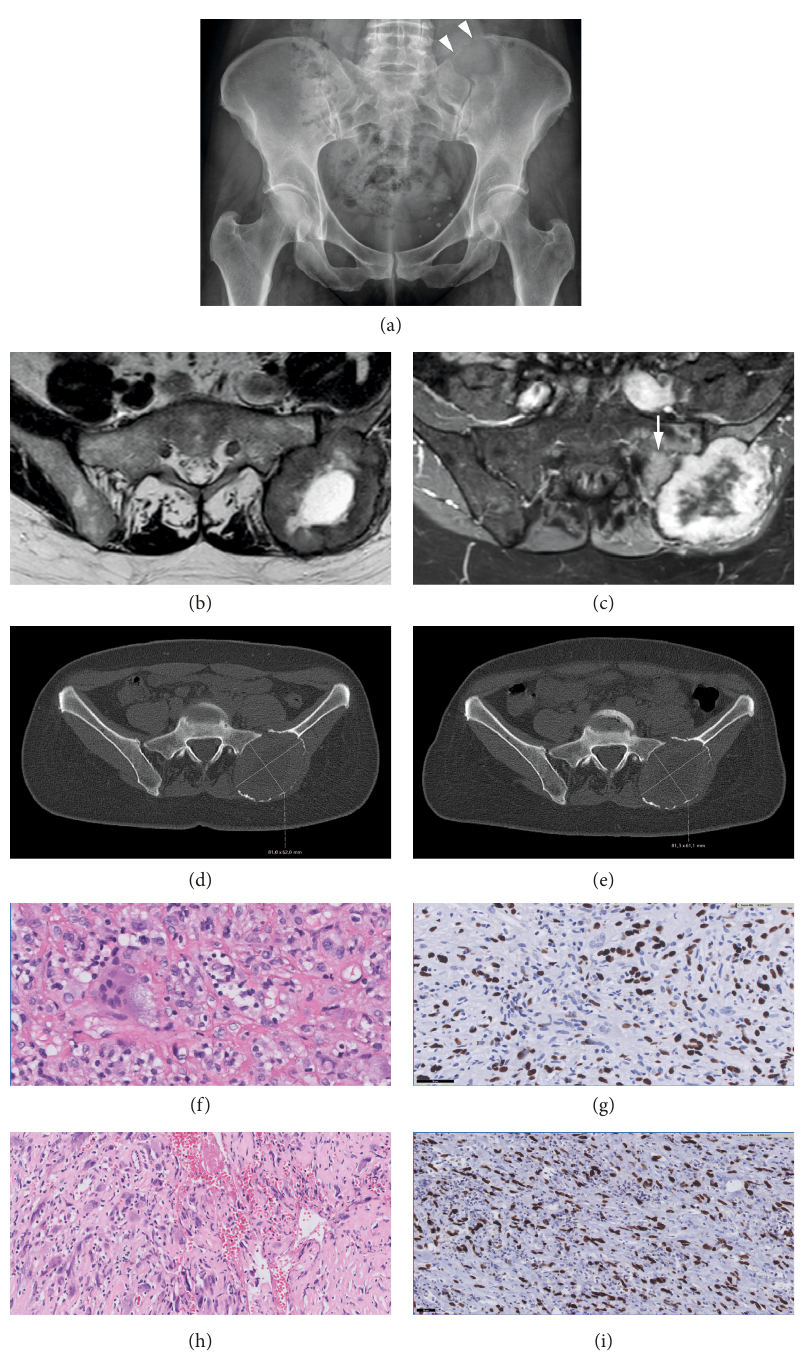
Figure 1: Case 1, a 54-year-old female with a GCTB in the left ilium. (a) X-ray at presentation shows an osteolytic tumor with cortical destruction (arrowheads) cranially in the left iliac wing, adjacent to the sacroiliac joint. (b) MRI at the time of diagnosis; axial T2 TSE shows an expansive tumor in the left posterior aspect of the ilium with central necrosis and a peripheral thick low signal intensity rim. (c) MRI at the time of diagnosis; T1 SPIR postgadolinium (Gd) shows heterogeneous enhancement, mainly of the tumor rim and adjacent bone marrow edema in the sacrum (arrow) and ilium. (d) Axial unenhanced CT images; 5 months after starting denosumab treatment and (e) 8 months after starting denosumab treatment. Both scans showed no decrease in size and no matrix formation centrally. No thick rim of neocortex was formed. (f) Histology; morphology of first biopsy confirmed the diagnosis of conventional GCTB: mononuclear stromal cells intermixed with osteoclast-like giant cells. The mononuclear cells have slightly enlarged nuclei and predominate over the giant cells, but since overt nuclear atypia and hyperchromasia and atypical mitoses are absent the diagnosis is still compatible with conventional giant cell tumor of bone. In the background reactive lymphocytes and some sclerosis. (g) Immunohistochemistry of the biopsy at the time of presentation: mononuclear stromal cells positive for H3G34W (scale bar 50 μ m). (h) Histology of resection after denosumab treatment showed malignant GCTB: atypical cells with enlarged hyperchromatic nuclei, scattered monstrous tumor cells, and atypical mitotic figures with matrix deposition suggestive of tumor osteoid. (i) Immunohistochemistry at the time of resection after denosumab treatment showed atypical stromal cells positive for